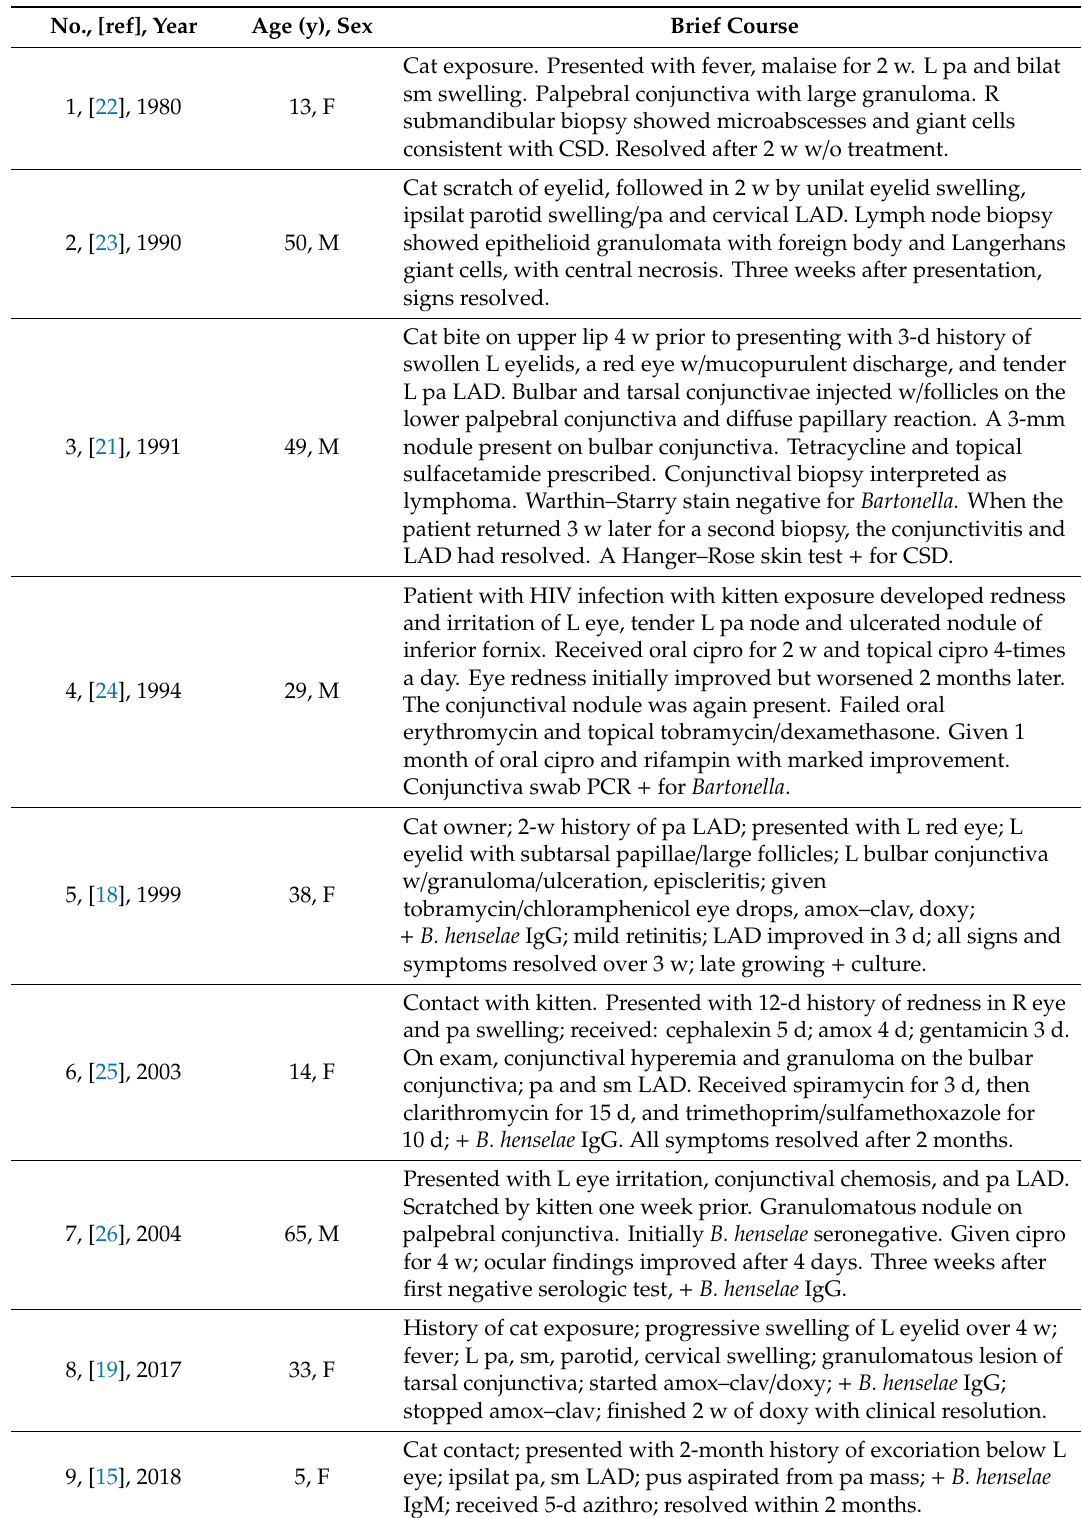
Table 2. Cases of cat scratch disease with